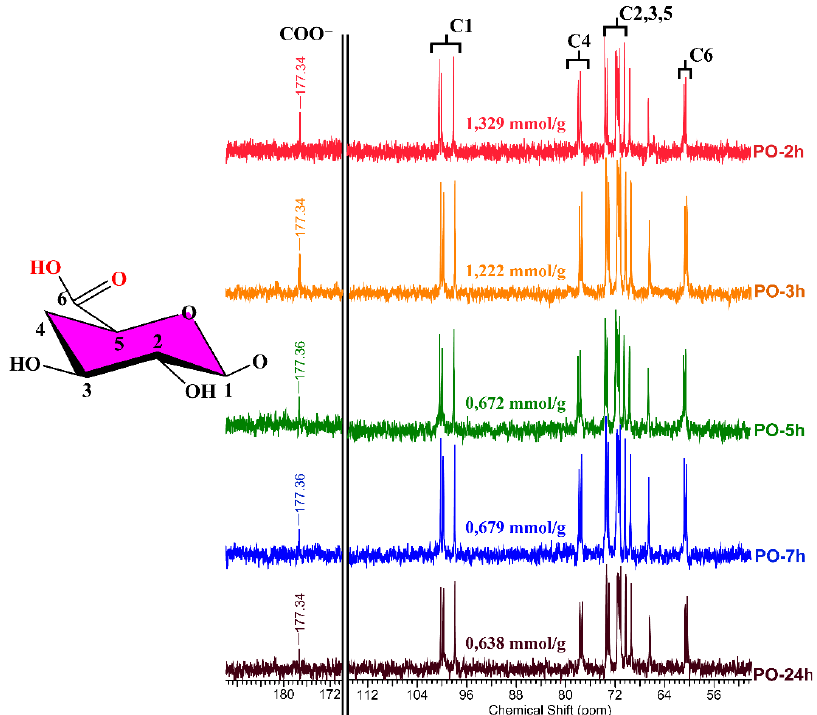
Figure 9. 13 C-NMR spectra of oxidized pullulan in the presence of H 2 O 2 /NHPI system (PO — oxi- dized pullulan at different reaction times). oxidized pullulan at different reaction